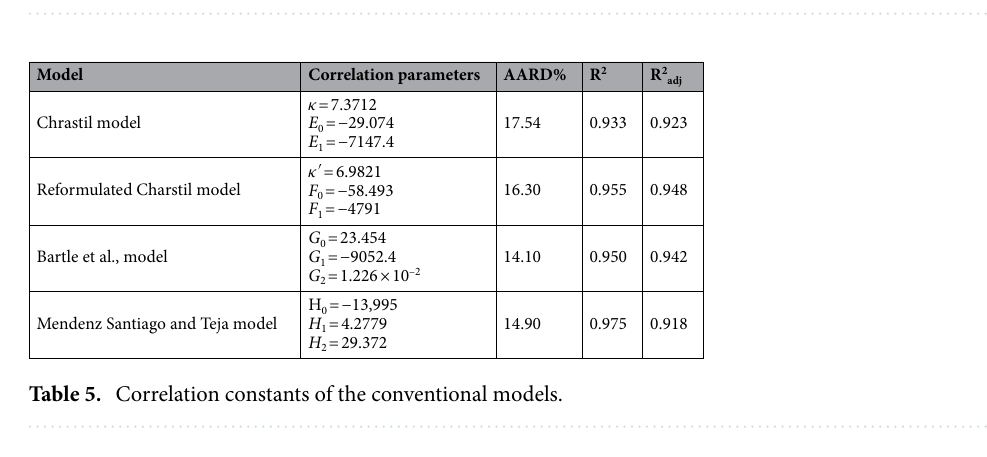
Figure 5. Pantoprazole sodium sesquihydrate solubility vs. ρ 1 . Lines are Alwi-Garlapati model calculations; dashed lines are Sodeifian et al., model calculations; dash dot lines are Reddy-Garlapati model calculations.